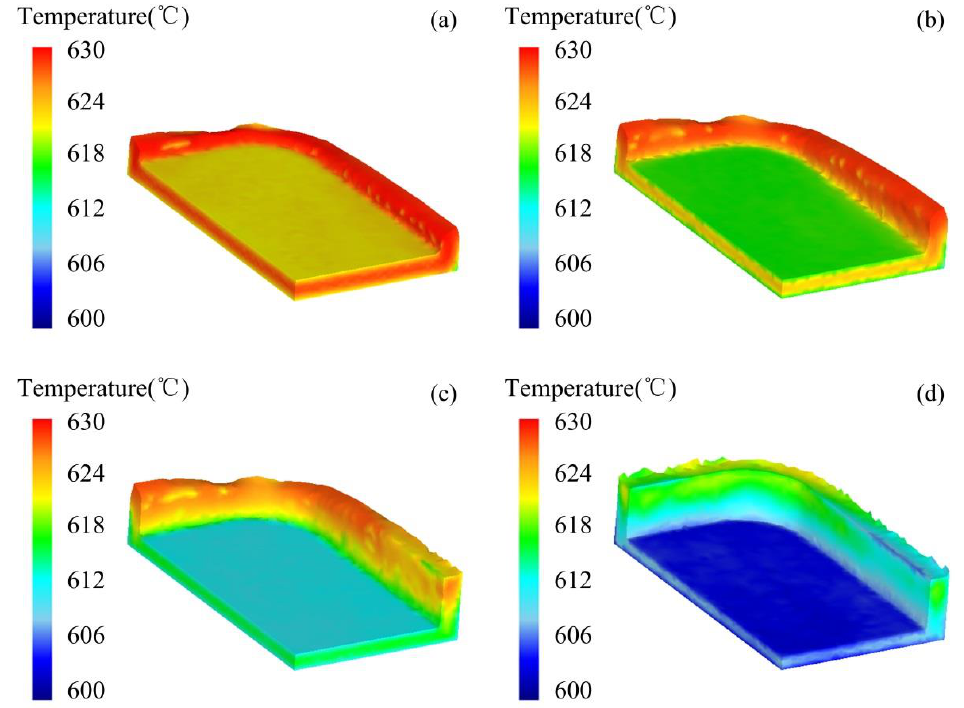
Figure 6. Temperature distribution during the filling process of mobile phone shell at ( a ) 0.25 mm, ( b ) 0.5 mm, ( c ) 0.75 mm, and ( d ) 1 mm displacements of the top mould. ( b ) 0.5 mm, ( c ) 0.75 mm, and ( d ) 1 mm displacements of the top